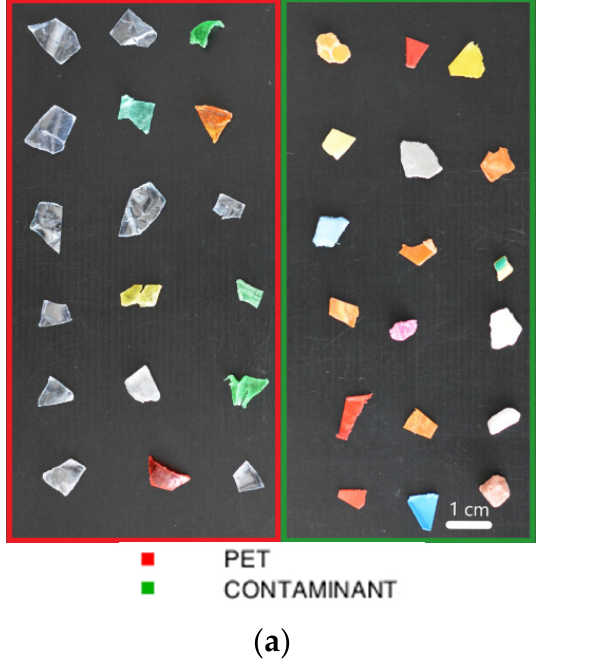
Figure 1. Source images of calibration dataset showing PET (red square) and contaminant (green square) flakes ( a ) and source image of the prediction dataset showing PET and contaminant flakes (the latter marked by green circles) ( b ).